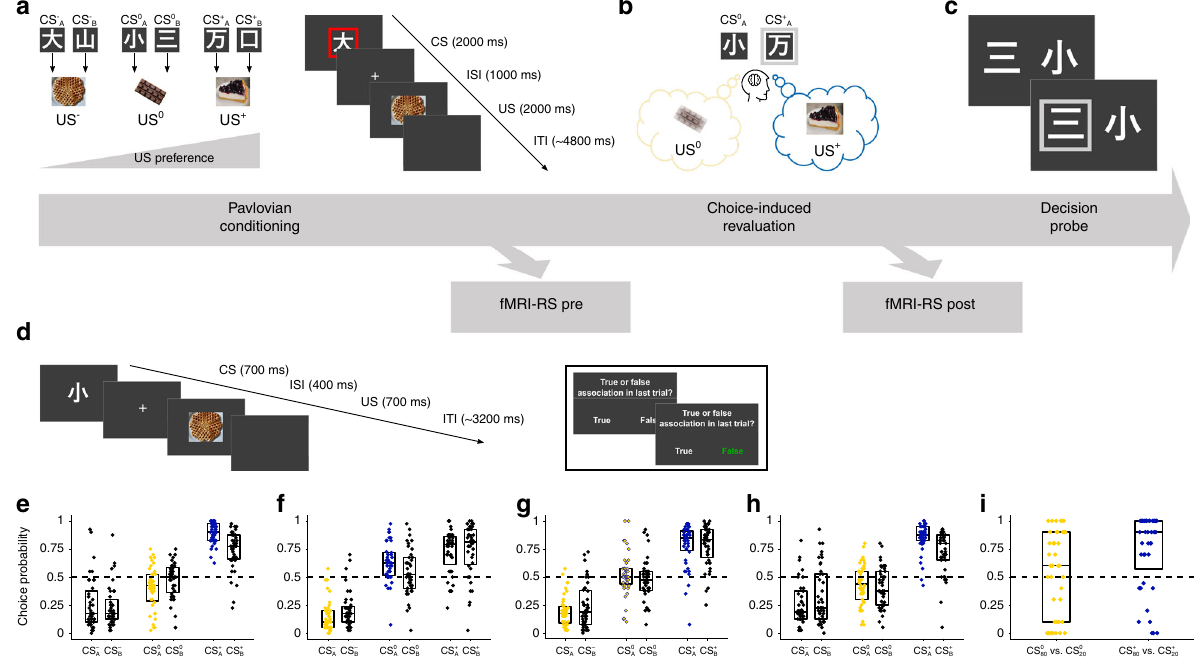
Fig. 1 Task schematic and behavioral results. a Participants rated subjective desirability of conditioned stimuli (CS, kanjis) and unconditioned stimuli (US, food items). Kanji images were selected from an online database (https://www.kanjidatabase.com/) 23 . During Pavlovian conditioning, participants